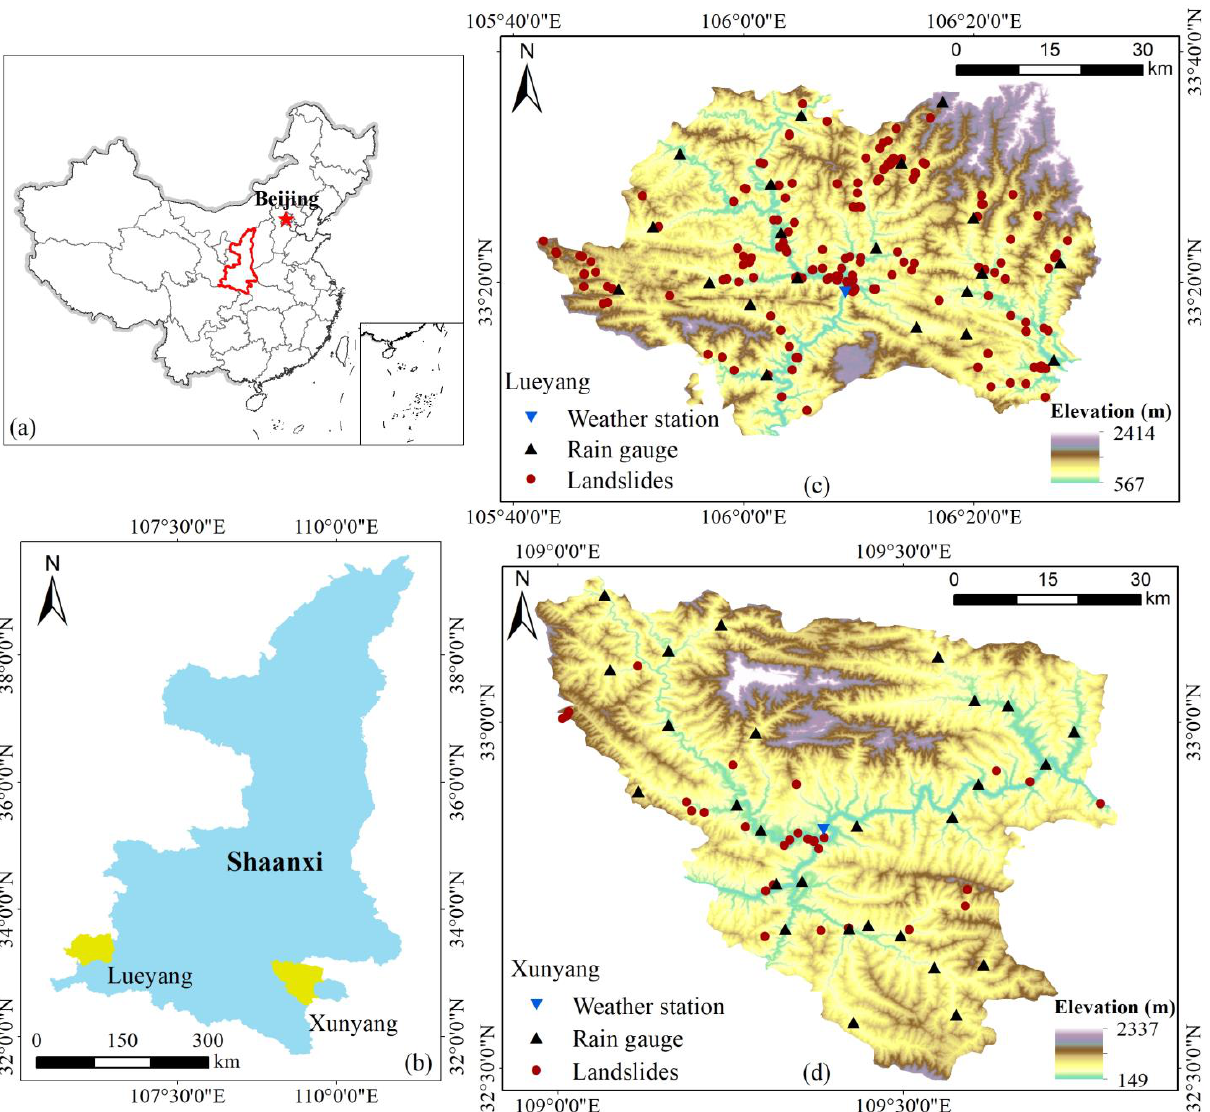
Figure 1. ( a ) Location of Shaanxi province; ( b ) location of Lueyang (LY) and Xunyang (XY) counties; ( c , d ) distribution of weather station, rain gauges, and landslides in LY and XY counties, respectively (image sources: SRTM V3 data). (image sources: SRTM V3